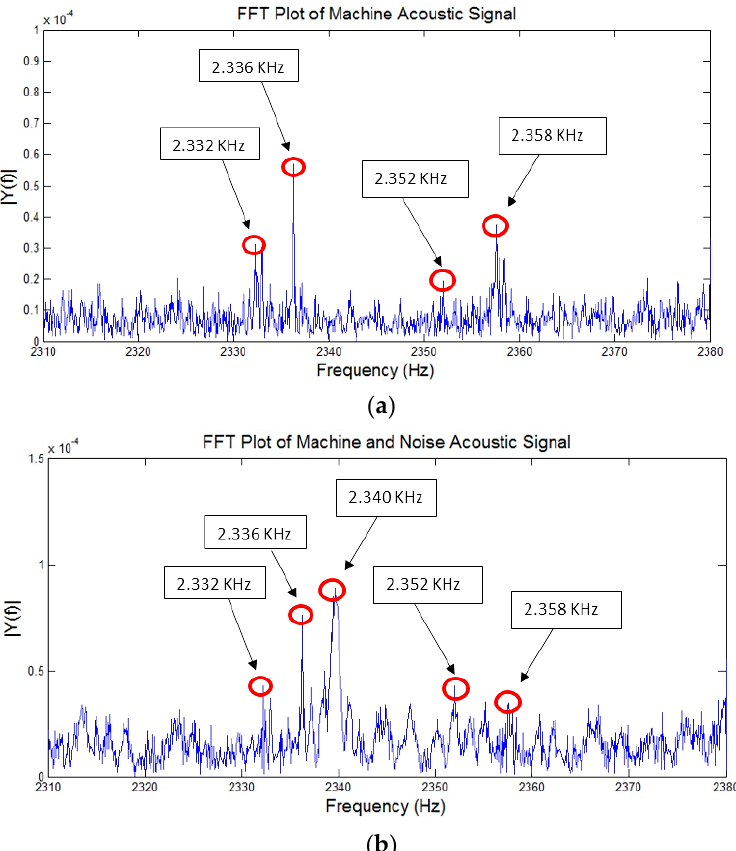
Figure 10. ( a ) FFT plot of an acoustic signal before noise addition (above); ( b ) FFT plot of an acoustic signal after noise addition (below).